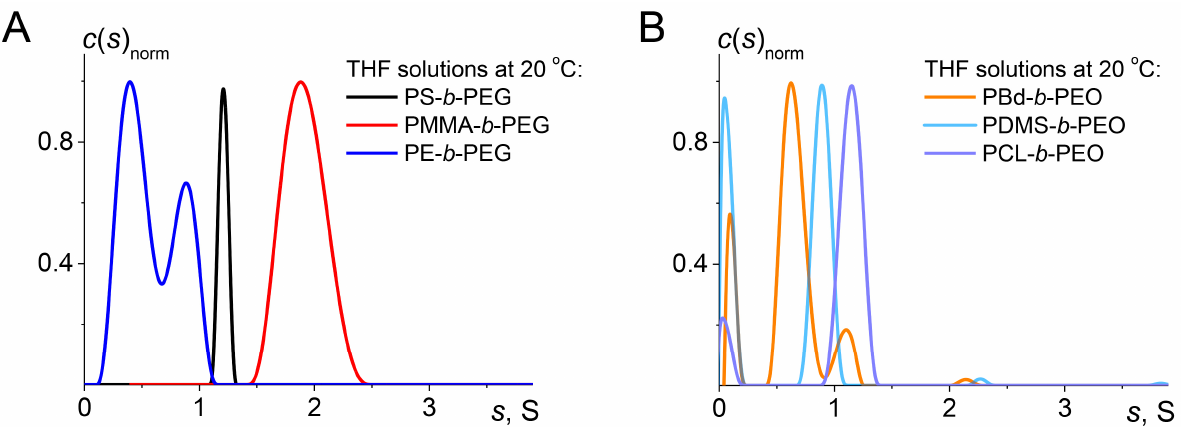
Figure 1. Normalized distributions c(s) norm on sedimentation coefficients resolved with “continuous distribution model” implemented in Sedfit software. The presented data correspond to the lowest concentrations of all block copolymers in THF solutions at 20 °C. ( A ) Systems that lack a sedimentation peak with low s values; and ( B ) systems that demonstrate a sedimentation peak with low s values.